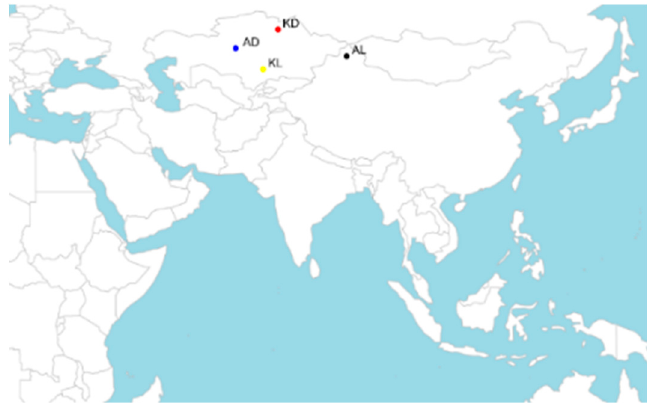
Figure A1. The geographical locations of four sheep breeds.